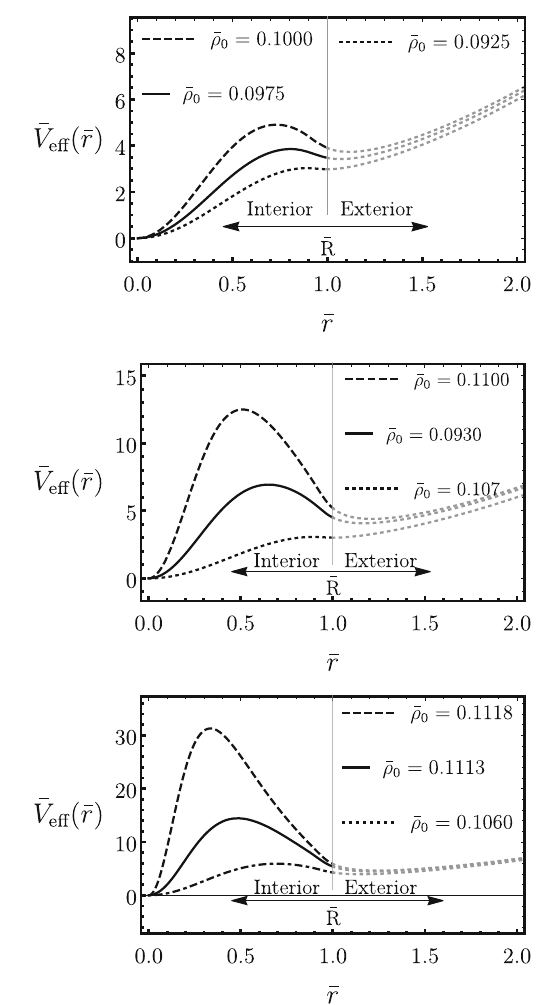
Fig. 11 ¯ V eff as a function of ¯ r , for ¯ ρ 0 = 0 . 100 (upper panel), ¯ ρ 0 = 0 . 110 (center panel), and ¯ ρ 0 = 0 . 113 (lower panel)